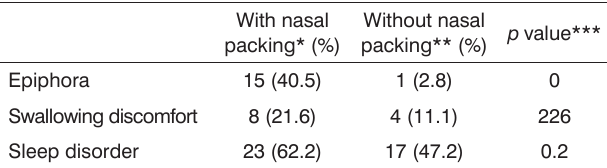
Table 3. Comparison of the incidence of epiphora, swallowing discomfort and sleep disorders in patients with and without nasal